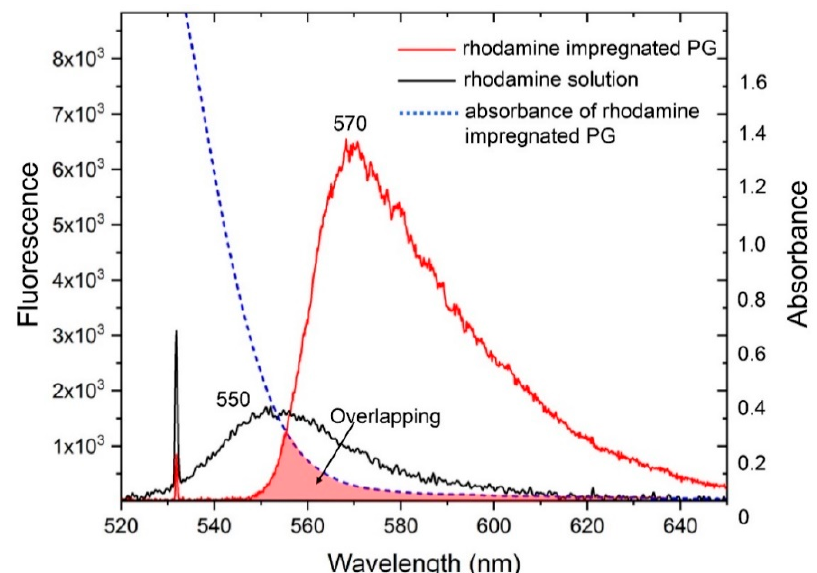
Figure 5. The spectrum curves of laser radiation transmitted through rhodamine 6G solution (0.835 × 10 − 3 mol/L) (black curve) and PG impregnated with the same solution (red curve). The absorbance spectrum of the rhodamine-impregnated PG, which was measured in Figure 1 (dashed blue curve) and applied here for the comparison.